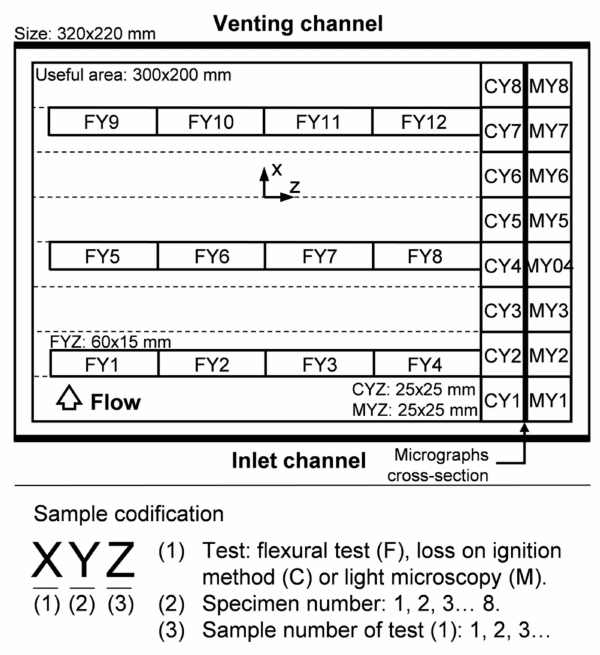
Figure 5. Generic pattern of samples: size, distribution, and codification